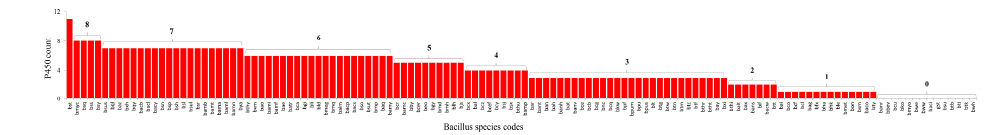
Figure 2. Comparative analysis of P450s in Bacillus species. The numbers next to bars indicate the number of P450s in Bacillus species. Bacillus species’ names with respect to their codes can be found in Supplementary Dataset 1.